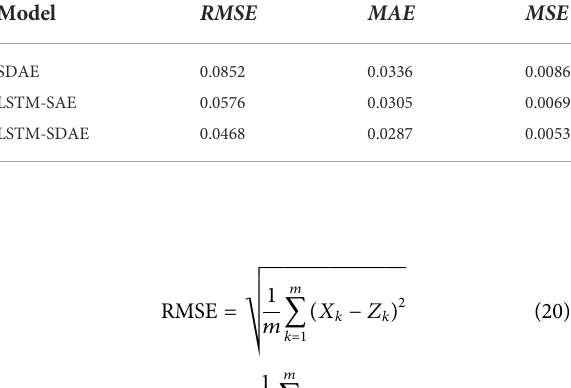
TABLE 5 Accuracy comparison of the three models.